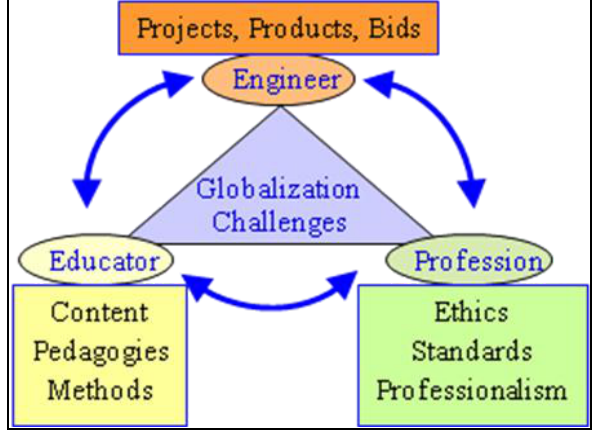
Figure 2. Globalization of engineering issues and